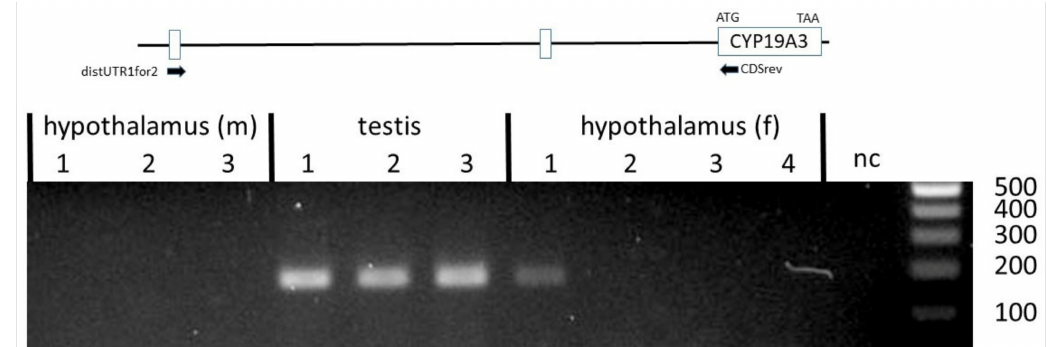
Figure 4. PCR products amplified with primers annealing to the distal untranslated exon 1 and CDS. A clearly visible band was found in all testis samples, a weak band only in hypothalamus of female #1. Annealing positions of corresponding forward and reverse primers in the distal untranslated exon 1 and the CDS of CYP19A3 are shown in the inserted Figure 1. this transcript variant was detected but represented by a considerably weaker band. These transcripts were also present in both peripubertal ovarian samples based upon sequencing of isolated PCR products (not shown). Direct sequencing analysis of PCR products and the presence of only one band in the gel clearly indicated that a sequence derived from distal untranslated exon 2 was not spliced into any of these